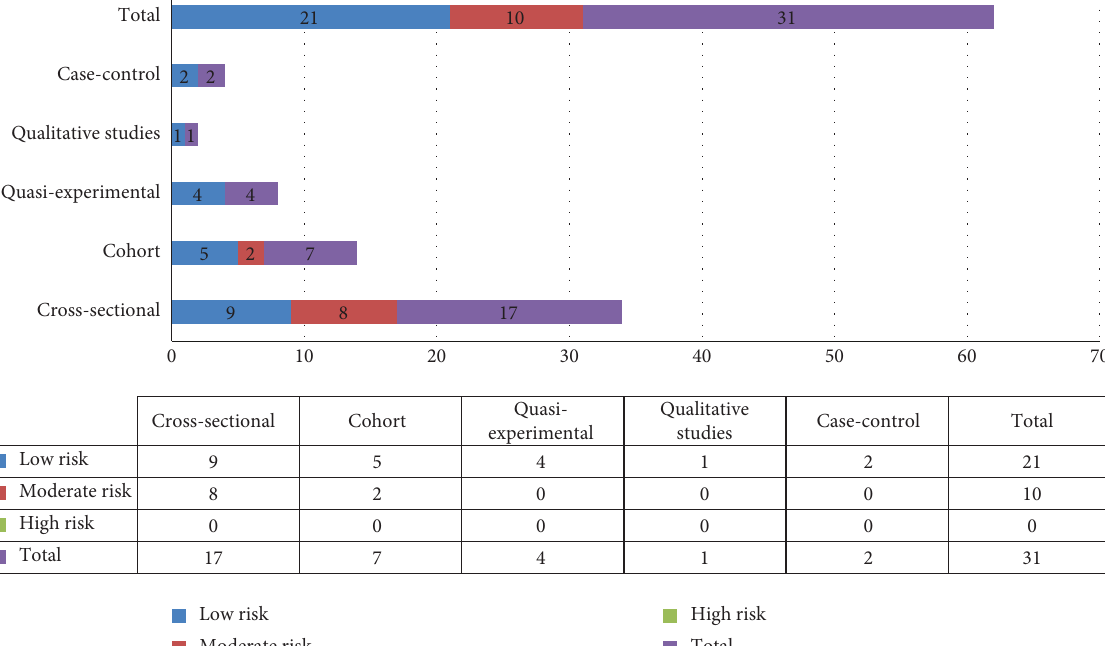
Figure 3: Quality assessment of the included papers.